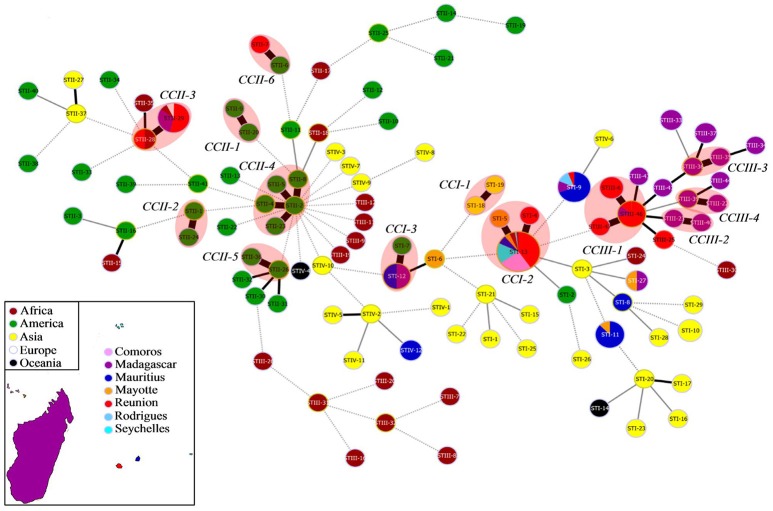
Minimum spanning tree (MST) from MLST data displaying genetic relationships between RSSC SWIO and worldwide reference strains (C3 collection, n = 235). MLST data are based on seven gene regions (gdhA, mutS, adk, leuS, rplB, gyrB, and egl). The dot colors indicate the country of isolation. Worldwide reference strains: Africa (brown), America (green), Asia (yellow), Oceania (black), Europe (white). SWIO strains: Reunion (red), Maurice (blue metallic), Comoros (pink), Madagascar (purple), Seychelles (turquoise), Rodrigues (sky blue) and Mayotte (orange). The labels in the dots indicate the MLST sequence type numbers (ST). Black thick lines, black regular lines, gray thin lines, and gray dashed lines joining haplotypes indicate single, double, triple, and more variations, respectively. No link is indicative of variations at >3 loci. Red halos denote a clonal complex (CC).